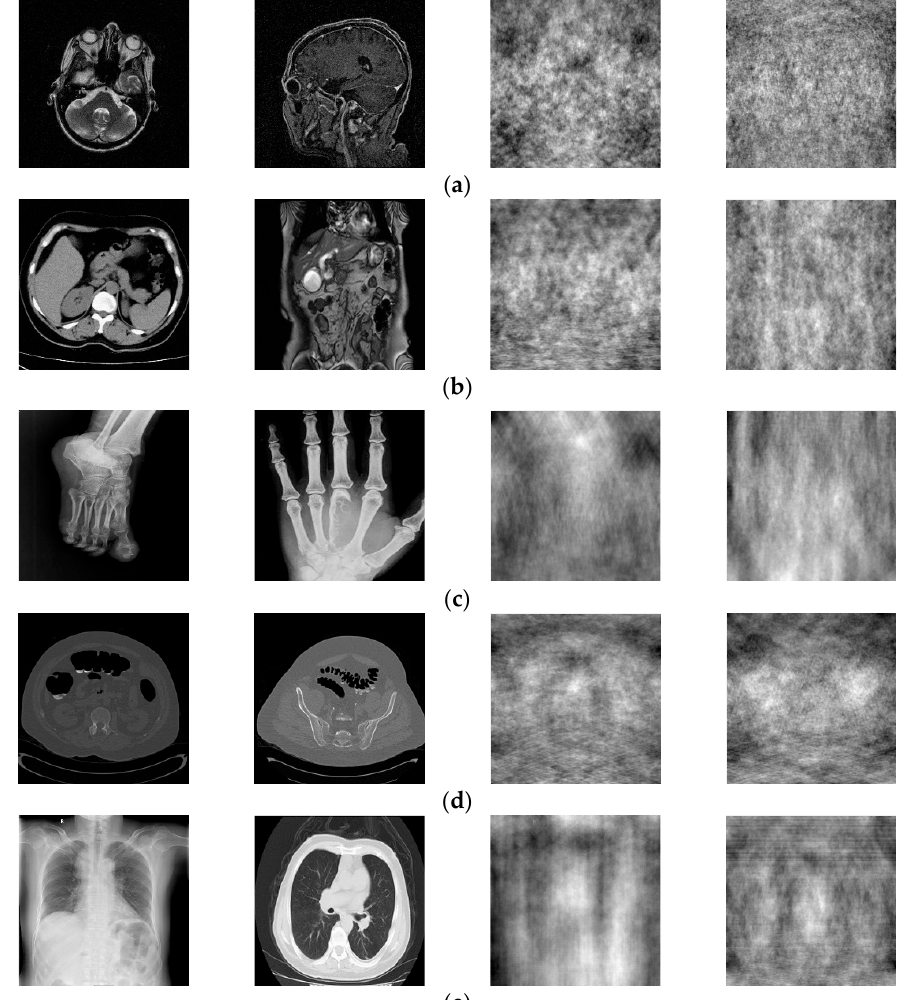
Figure 5. Two original images and corresponding encrypted images for each type of image. Brain image ( a ); abdominal pelvis image ( b ); bone muscle image ( c ); colon image ( d ); and chest image ( e ). Table 1. Specific implementation operations for data